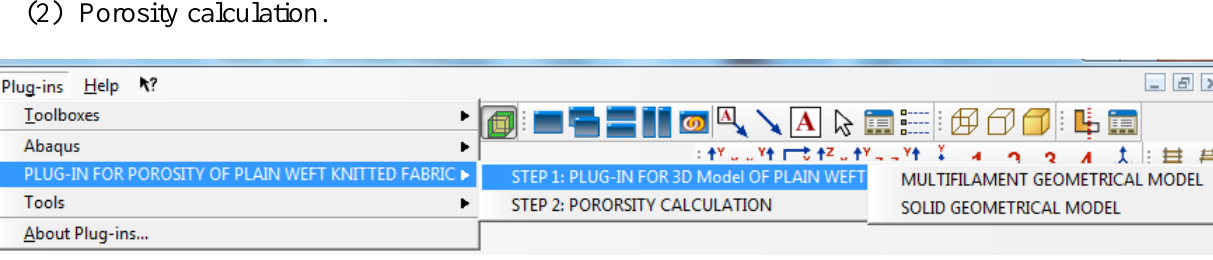
Figure 1. Plug-in for porosity of plain weft knitted